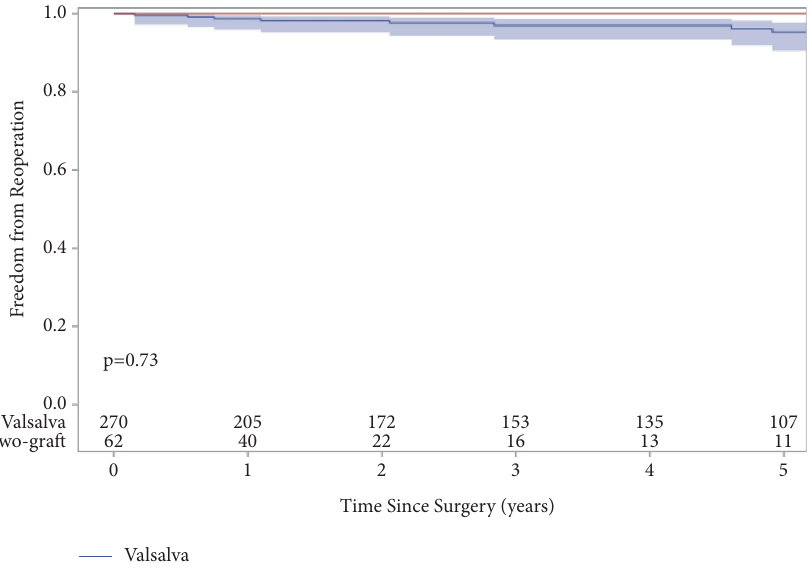
Figure 3: Freedom from reoperation for aortic insufciency after valve-sparing aortic root replacement with either the David-V-Valsalva graft (5-year: 93%) or David-V-Smod (5-year:100%) techniques showed no diference between the two implantation techniques ( p � 0 . 29).